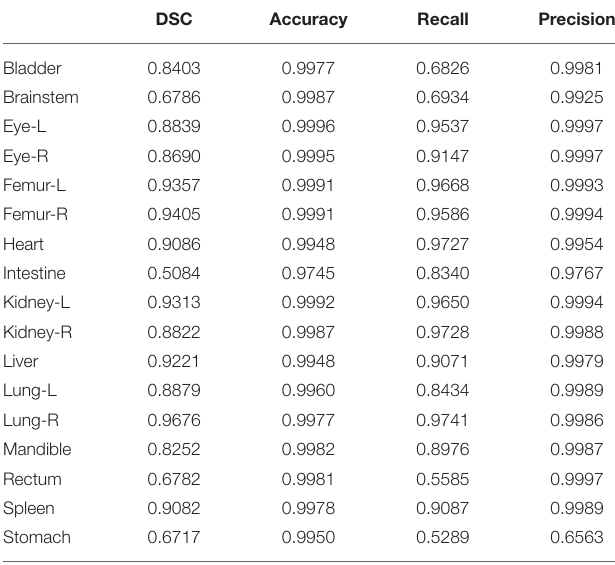
TABLE 2 | Evaluation for the automatic organ segmentation. DSC